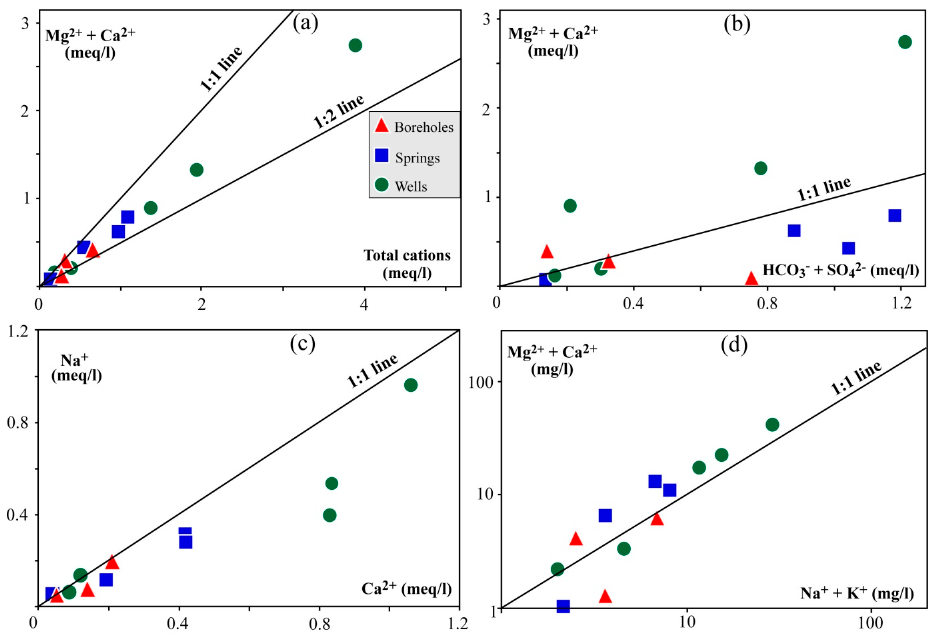
Figure 6. Cross-plots showing the interrelationship among dissolved species: ( a ) (Mg 2+ + ca 2+ ) vs. Total cations; ( b ) (Mg 2+ + ca 2+ ) vs. (HCO 3 − +SO 42 − ); ( c ) Na + vs. Ca + ; ( d ) (Mg 2+ + ca 2+ ) vs. (Na + + Ca + ) diagram, modified after Henry and Wassenaar [54].